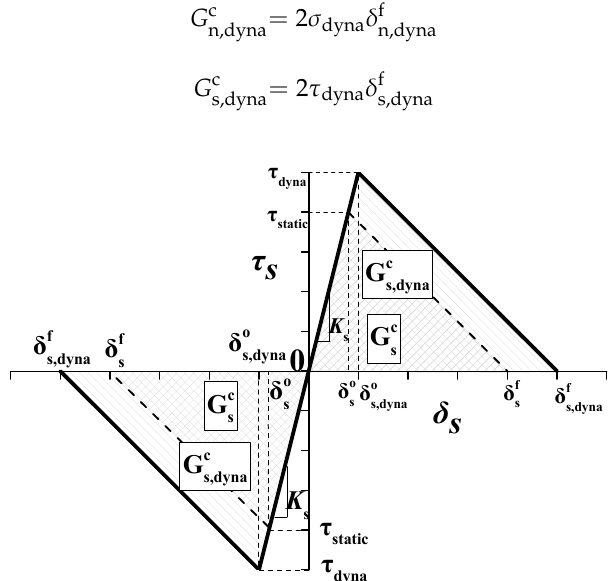
Figure 3. Rate-dependent TSL for shear direction.